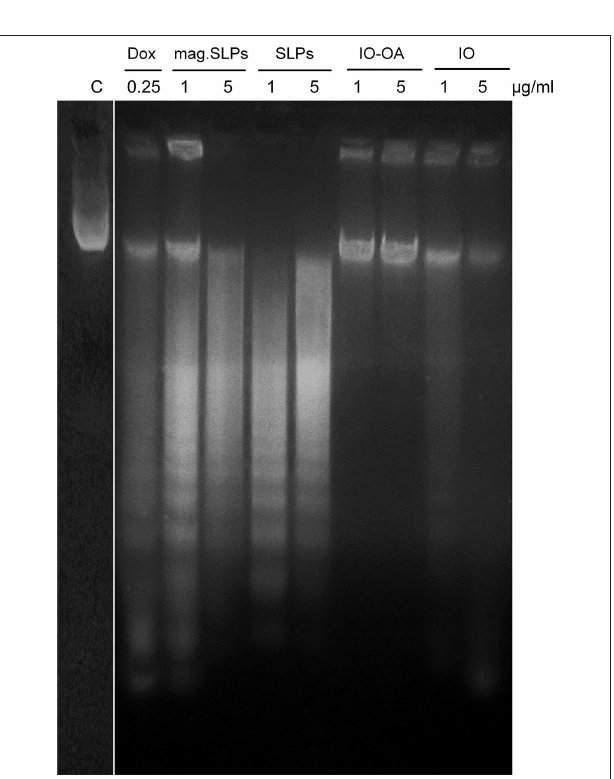
FIGURE 8 | DNA ladder (electrophoresis in 1.5% agarose gel) of Jurkat cells treated for 24h with doxorubicin (Dox; 0.25 µ g/ml), mag.SLPs, SLPs, IO-OA, and IO (all particles at 1 and 5 µ g/ml). C - non-treated control cells.